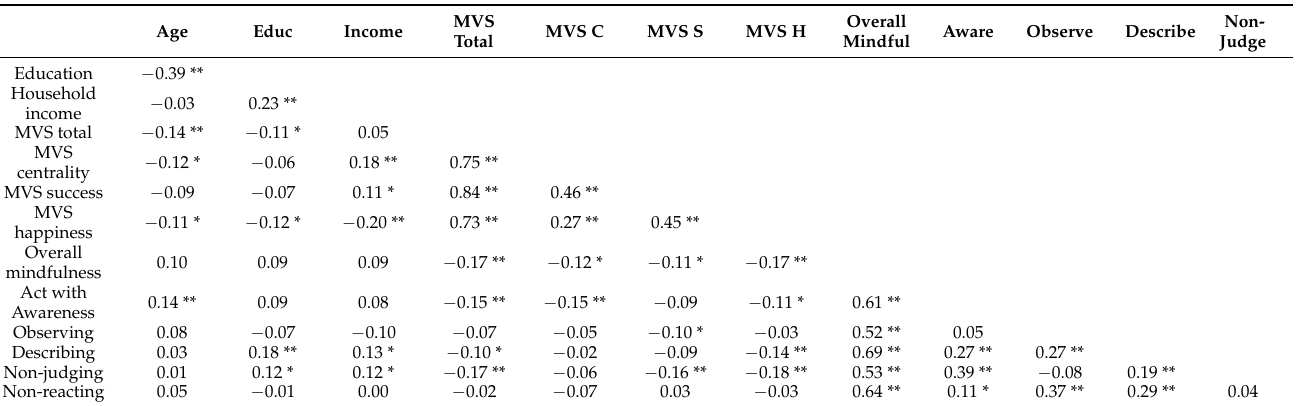
Table 4. Correlations among all variables including facets of mindfulness and materialistic